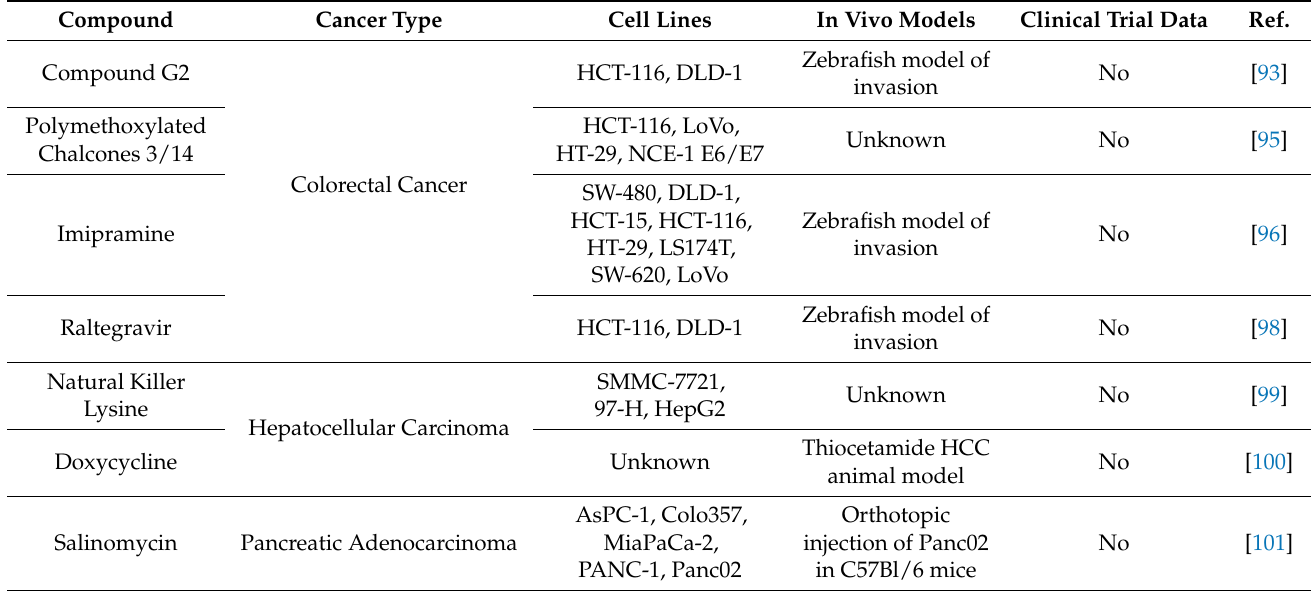
Table 2. Description of the experiments that examined the inhibitory effects of different compounds on fascin-1 expression in colorectal cancer, hepatocellular carcinoma, and pancreatic adenocarcinoma. Compound Cancer Type Cell Lines In Vivo Models Clinical Trial Data